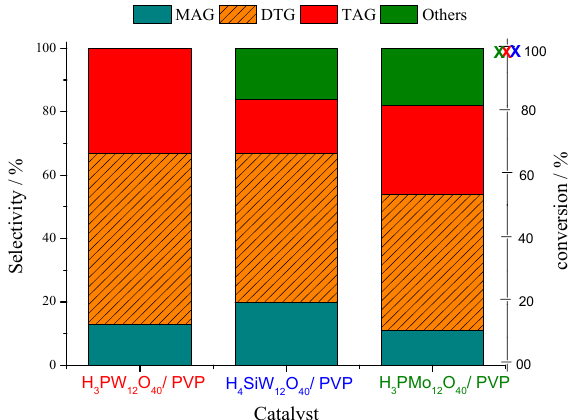
Figure 9. Glycerol esterification with acetic acid over polypyrrole polymer-supported Keggin HPAs (HPA/PVP) (adapted from ref. [51]).